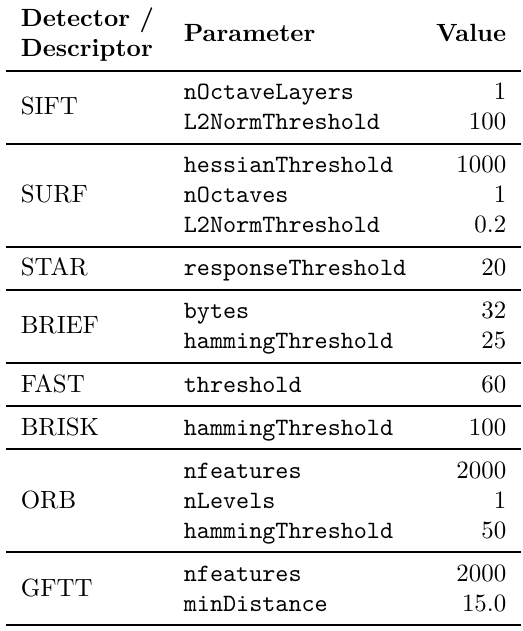
Table 1. Parameters used for feature detectors and